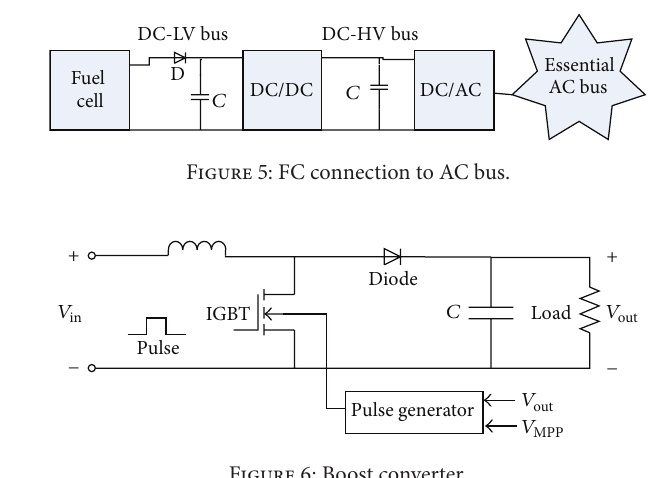
Figure 6: Boost converter.